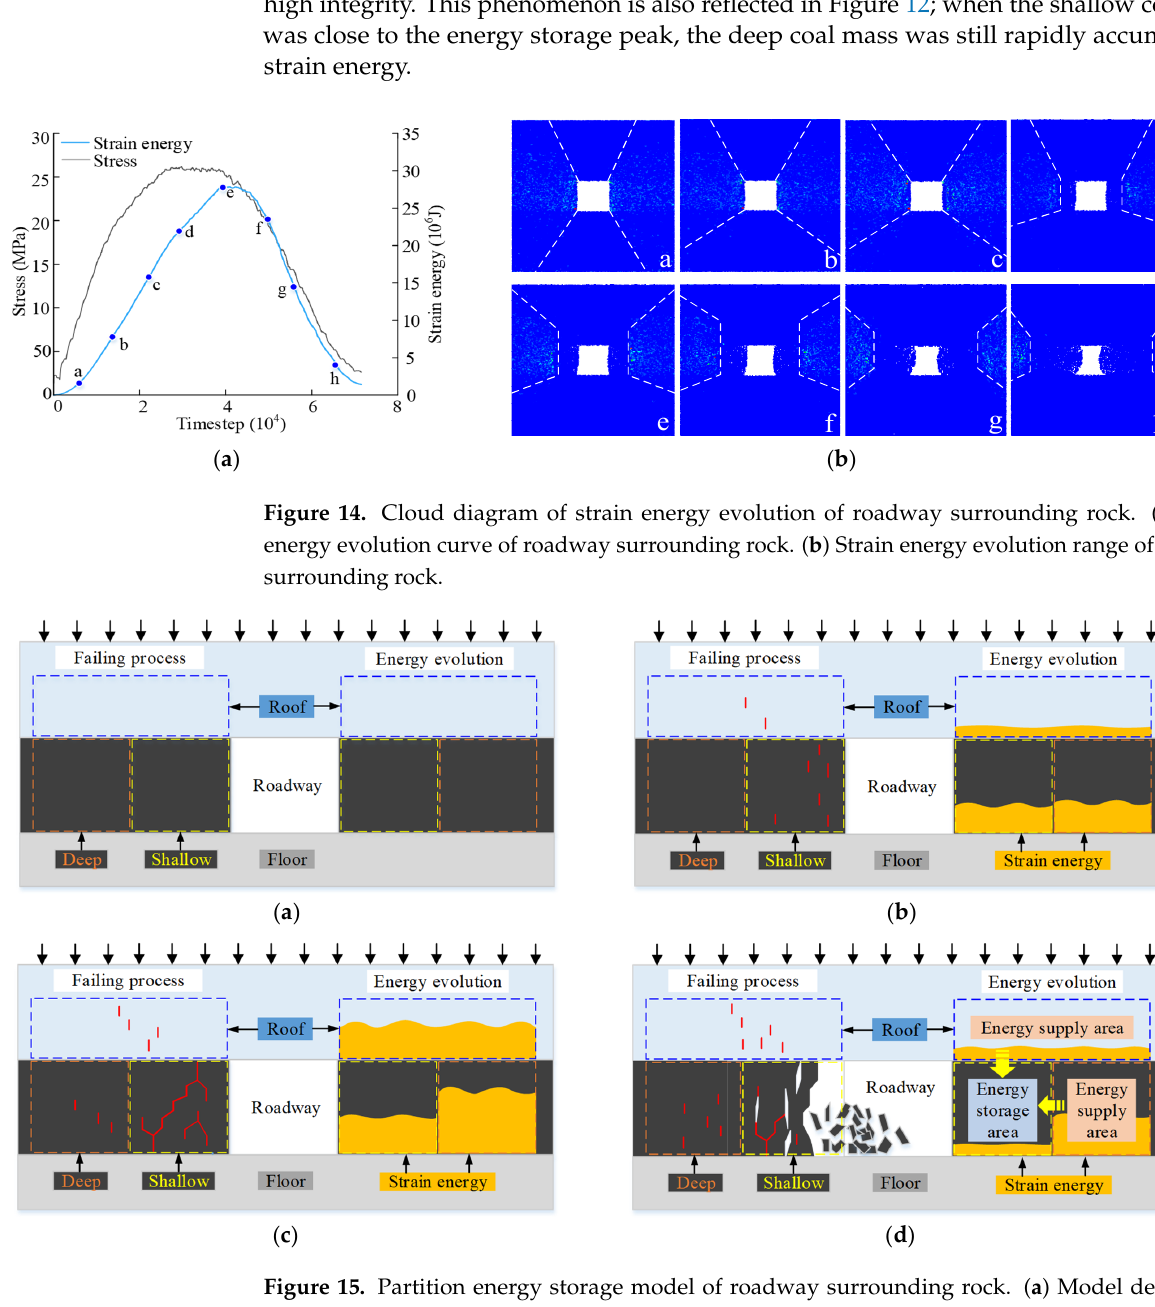
Figure 15. Partition energy storage model of roadway surrounding rock. ( a ) Model description. ( b ) Initial stage of strain energy accumulation. ( c ) Intermediate stage of strain energy accumulation. ( d ) Peak stage of strain energy accumulation.